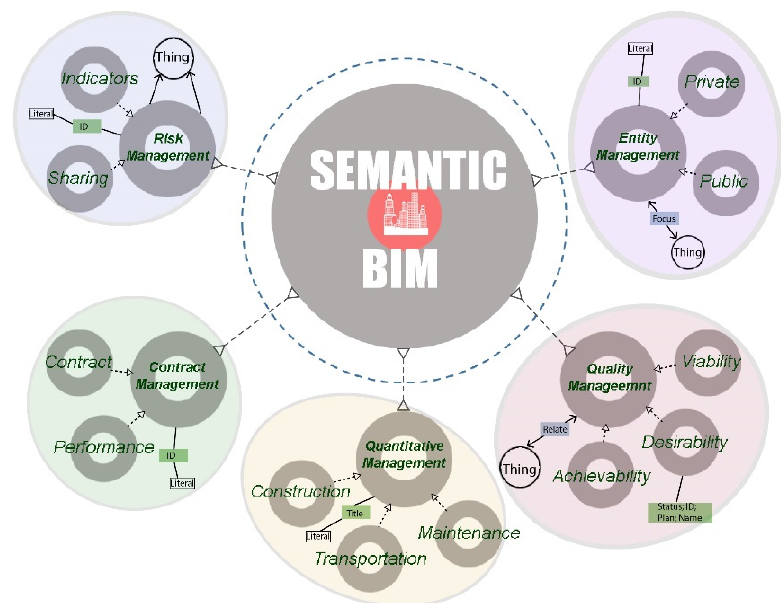
Figure 8. BIM aligned with the semantic function.